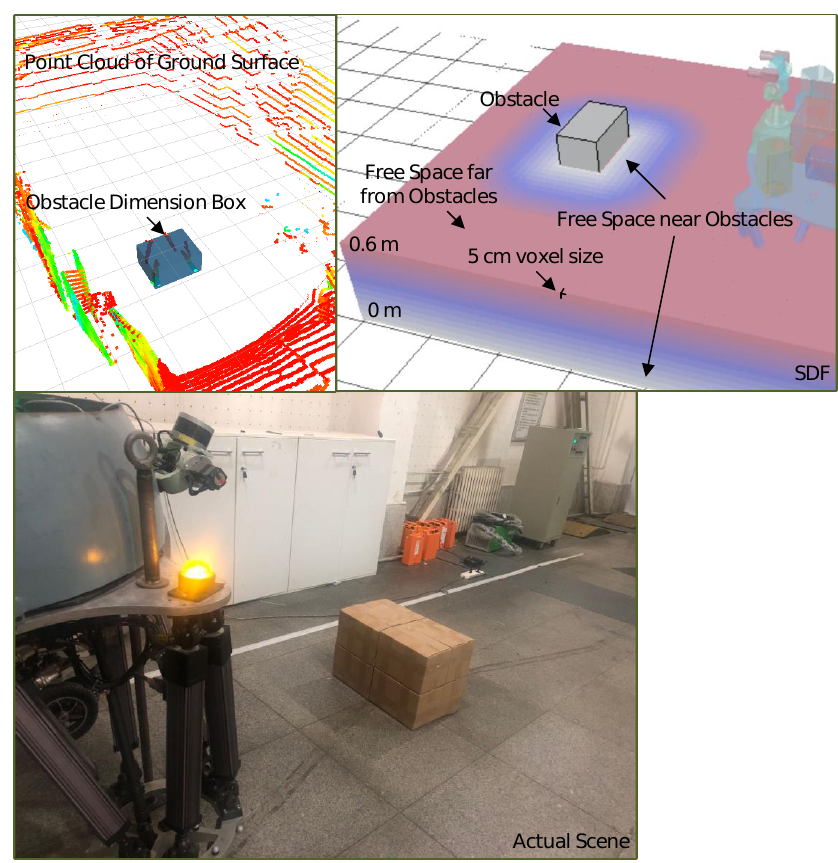
Figure 5. Obstacle description visualization in different